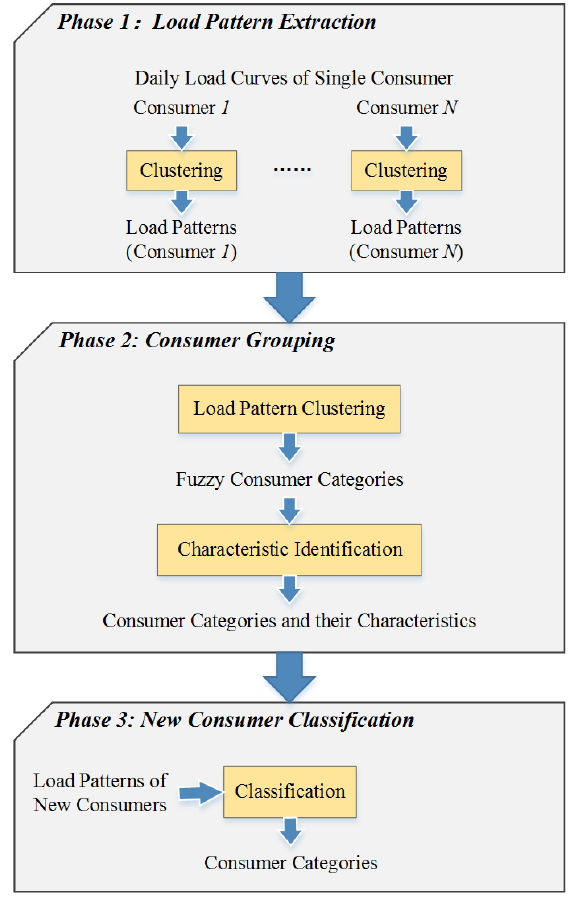
Figure 1. The model framework for electricity consumer categorization based on load pattern